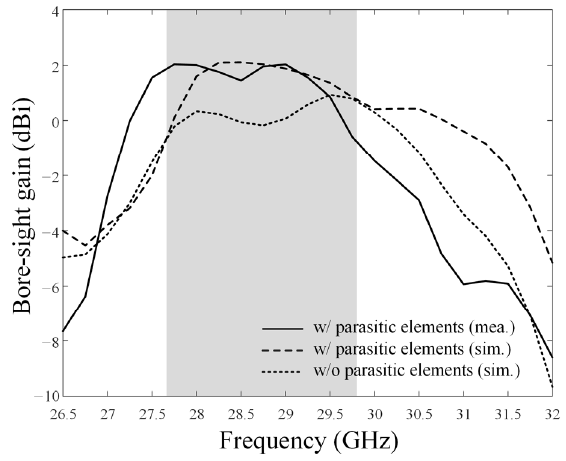
Figure 5. Reflection coefficient of the proposed antenna.